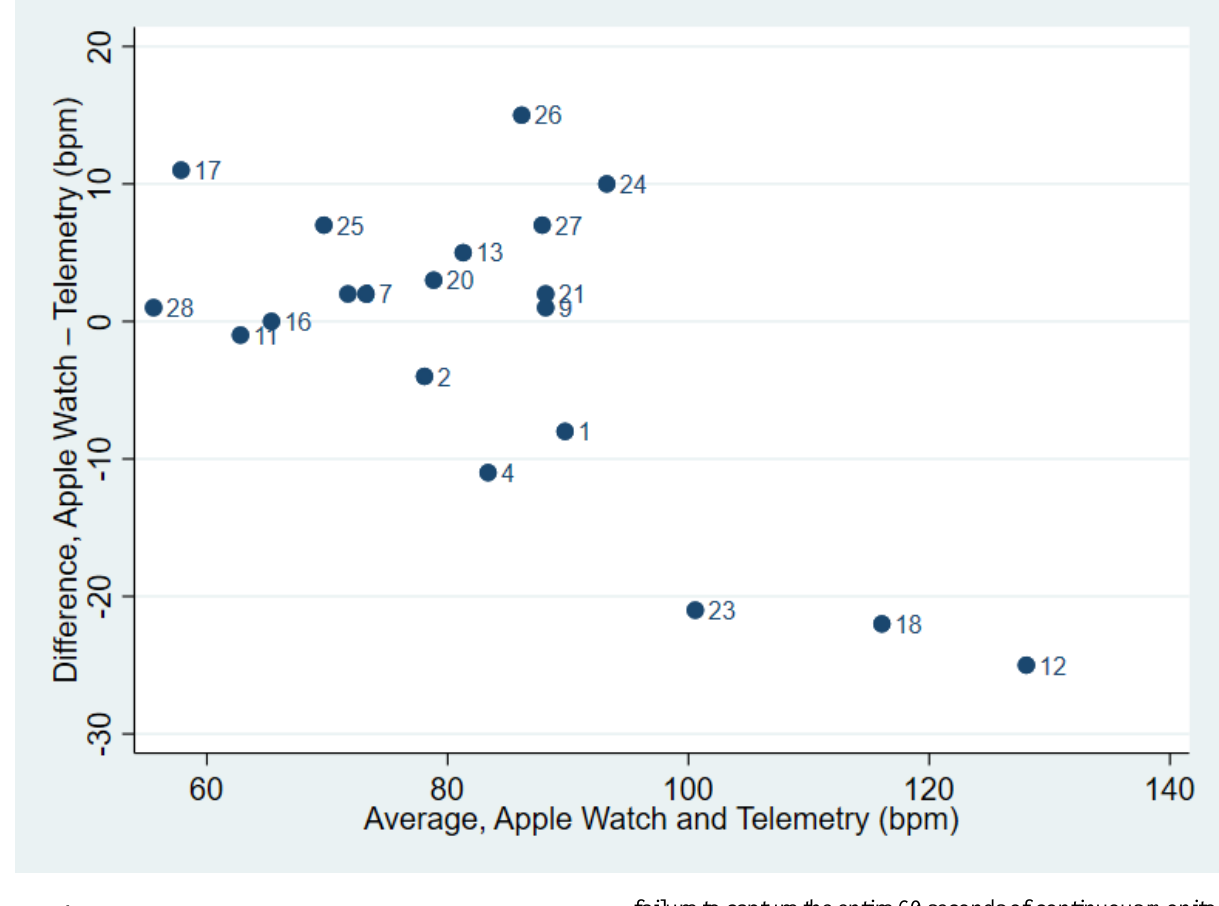
Figure 2. Scatter plots of standard deviation of measurement pair differences against patient mean. (Patients 23, 18, 12 had rapid ventricular response.) Here, we show a relationship between difference and magnitude of measurement, suggesting a violation of constant bias